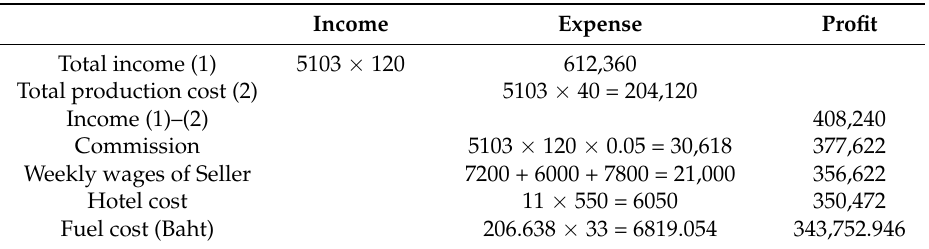
Table 11. Cost calculation of the visiting plan shown in Table